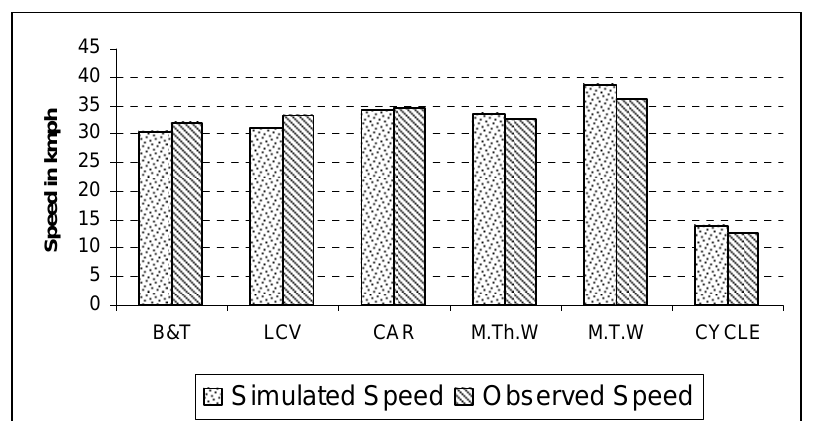
Figure 6. Comparison of observed and simulated speeds – Motorised Three-Wheelers, M.T.W. - Motorised Two-Wheelers